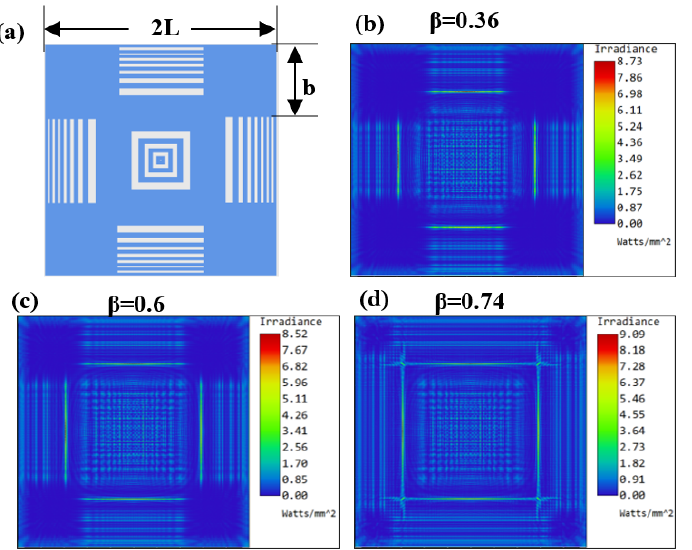
Figure 11. ( a ) Schematic diagram of PB-FZP; the diffraction pattern of PB-FZP with different values of transmittance parameter β : ( b ) β = 0.36; ( c ) β = 0.6; ( d ) β = 0.74.